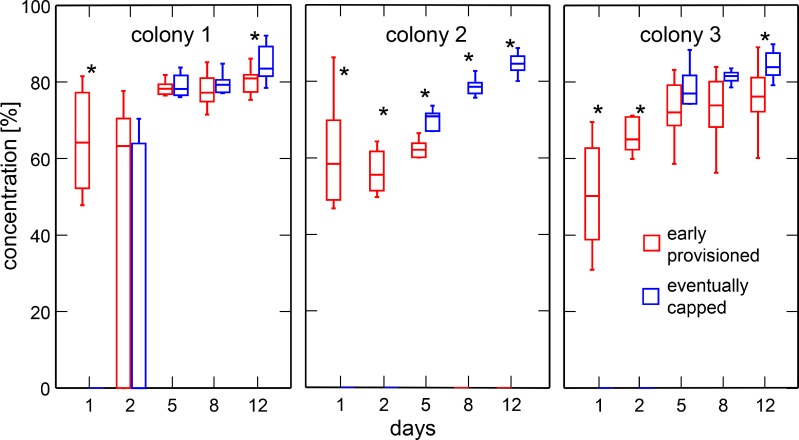
Comparison of sugar concentrations between cells provisioned early and eventually capped.Medians, first and third quartiles as well as range are shown. Sample size is 10 cells per box. For clarity, outliers identified by Systat are not shown. Significant differences between cell types are indicated with * (Wilcoxon-Mann-Whitney test, P < 0.025).